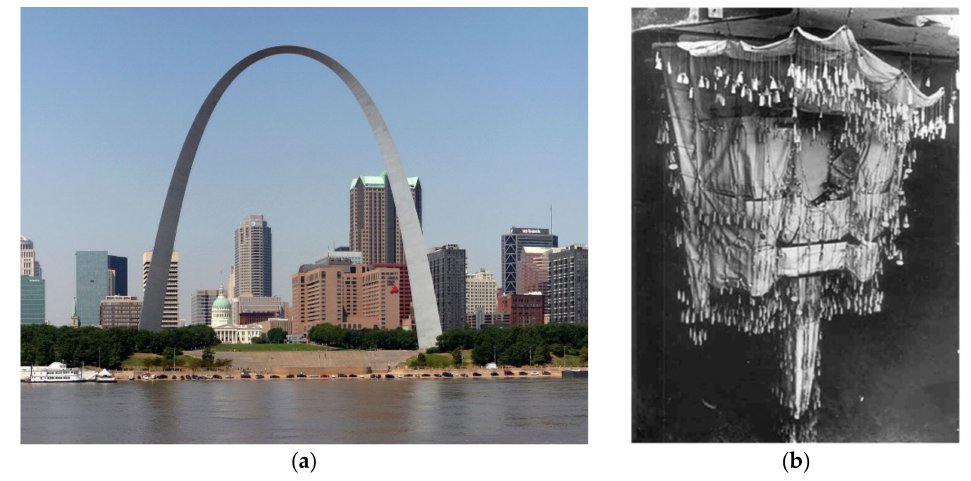
Figure 1. ( a ) The Gateway Arch in St. Louis, USA [9]; ( b ) Gaud í ’s hanging model